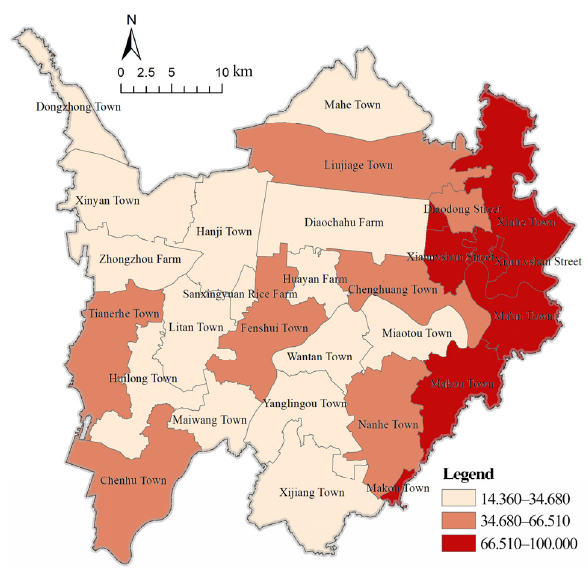
Figure 4. Spatial distribution of potential urban–rural integration development in each town of Hanchuan City.